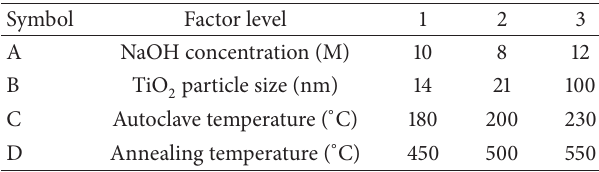
Table 1: Level of process parameters.